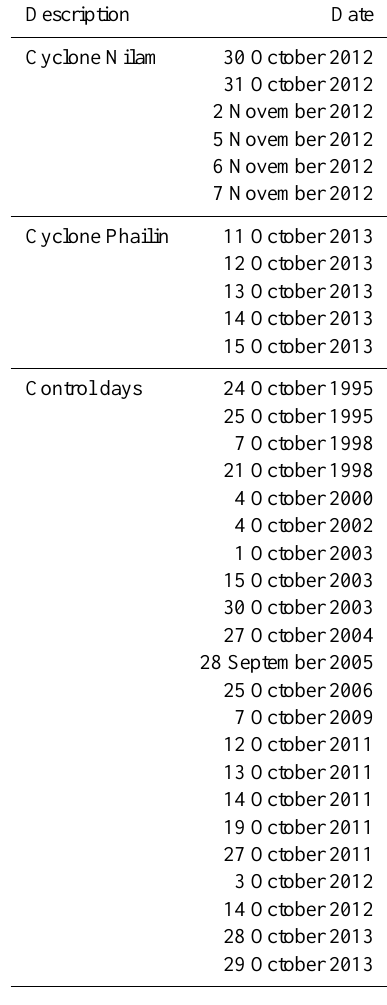
Table 1. Details of ozonesonde launched from Trivandrum includ- ing the historical data for control day